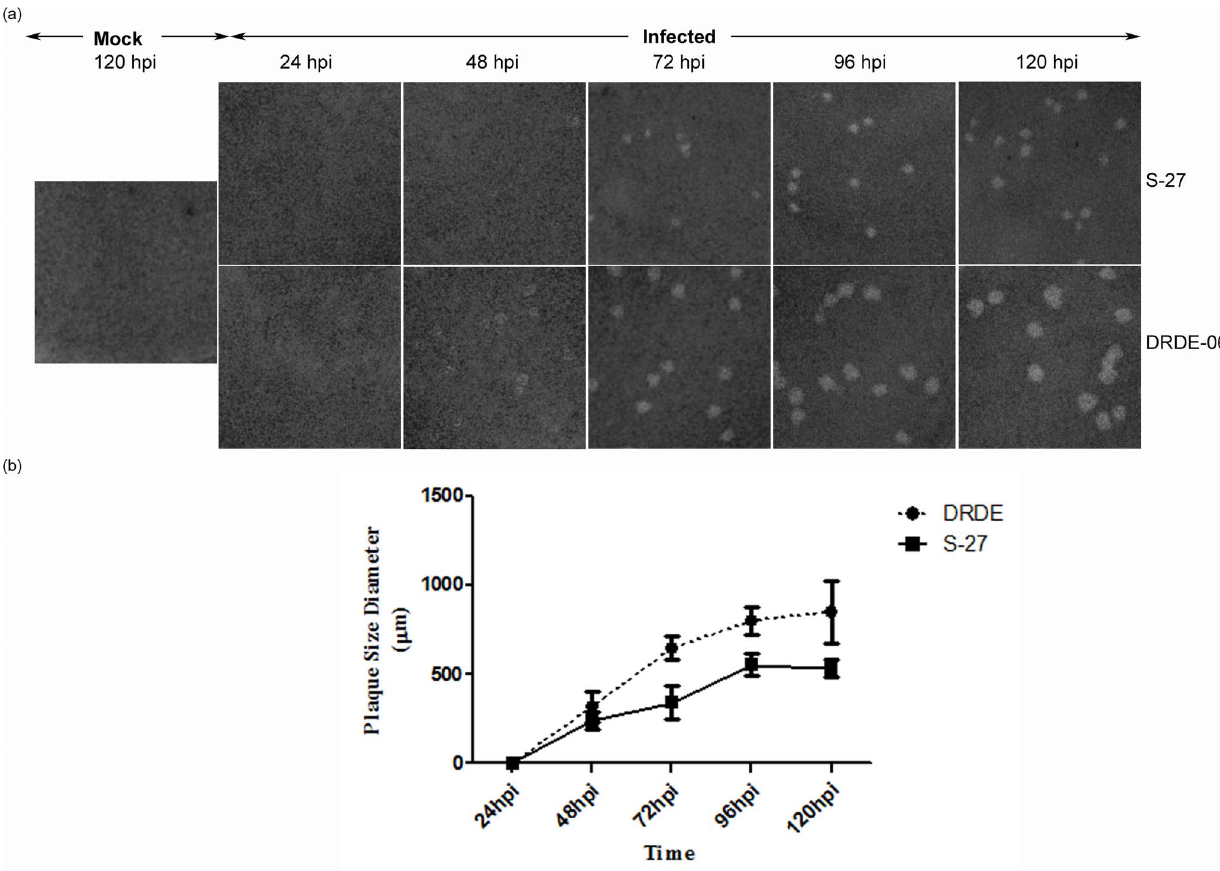
Figure 2. Proliferation kinetics of S-27 and DRDE-06 Chikungunya virus strains. Plaque assay was carried out in Vero cells (a) Representative pictures showings the progressive plaque formation at different time points. (b) Average plaque sizes at different time points were calculated based on the diameter of 10 randomly picked plaques of three independent experiment (p , 0.05).